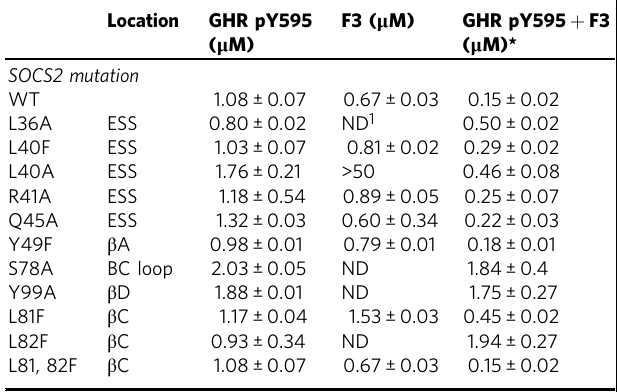
Table 2 Mutation of SOCS2 impacts the binding of F3, but not GHR pY595